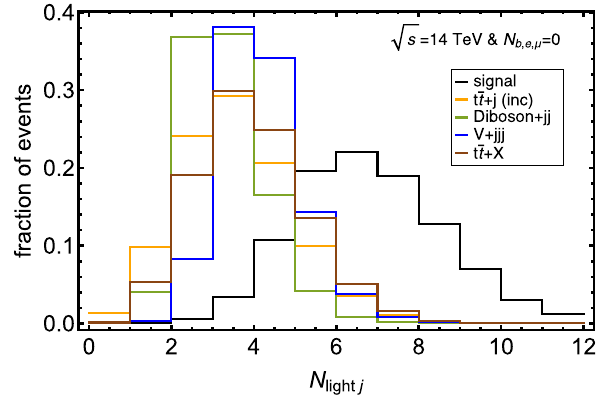
Fig. 2 Distributions of the fraction of signal and background events corresponding to the number of tagged light jets N